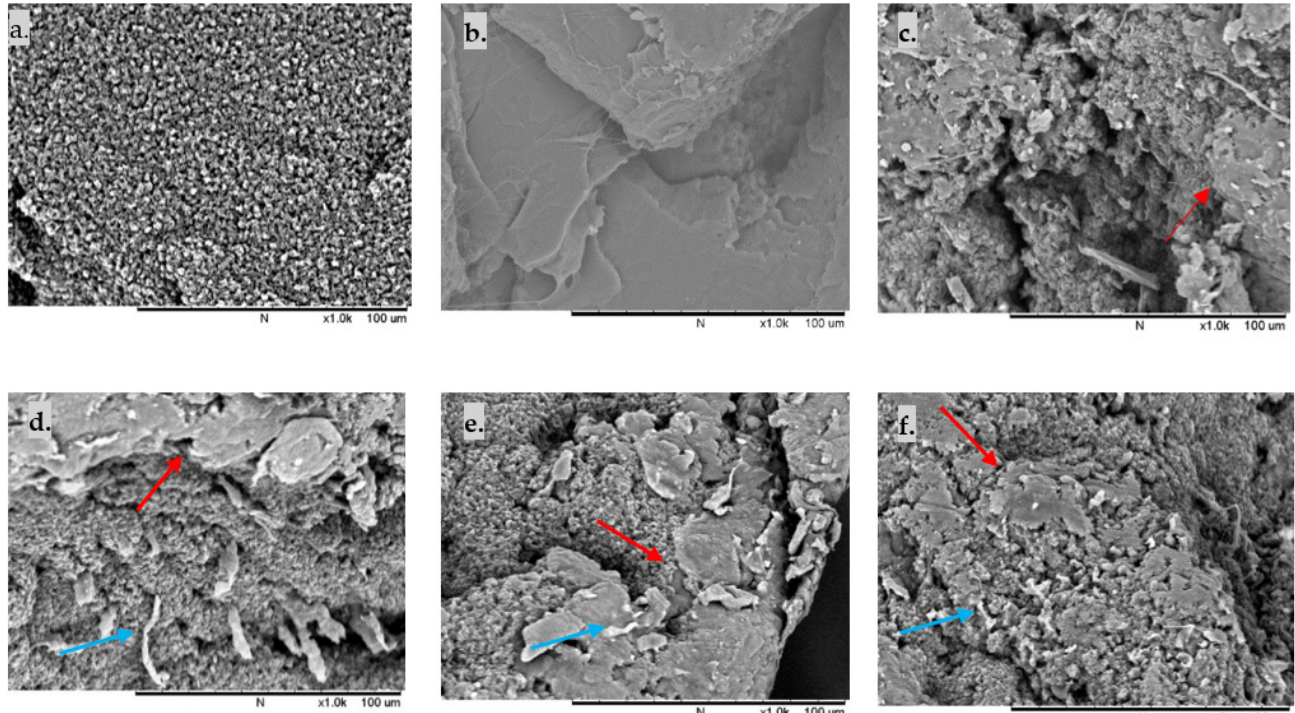
Figure 2. Cross-section SEM images of reactively extruded films: ( a ) 100/0, ( b ) 0/100. Homogeneous matrices are present in pure TPU and pure PLA ( c ) 90/10, ( d ) 80/20, ( e ) 70/30, ( f ) 60/40. Some fibrous TPU is present in the polymer blends, with PLA domains are dispersed in TPU matrices in all blends. Red arrows show PLA particles in the TPU matrix, while blue arrows indicate the fibrous TPU of the fractured surface. Scale bar of 100 μ m.